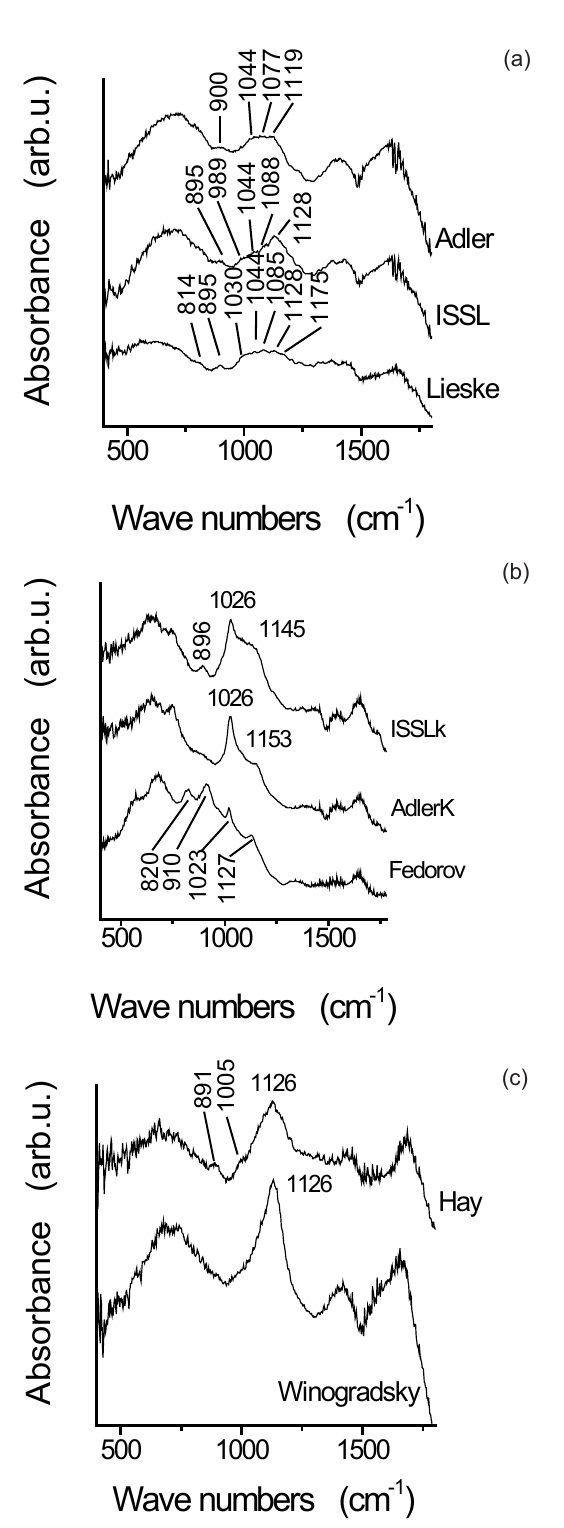
Figure 10. DRIFT spectra of samples obtained after iron bacteria cultivation and activity/life in different feeding